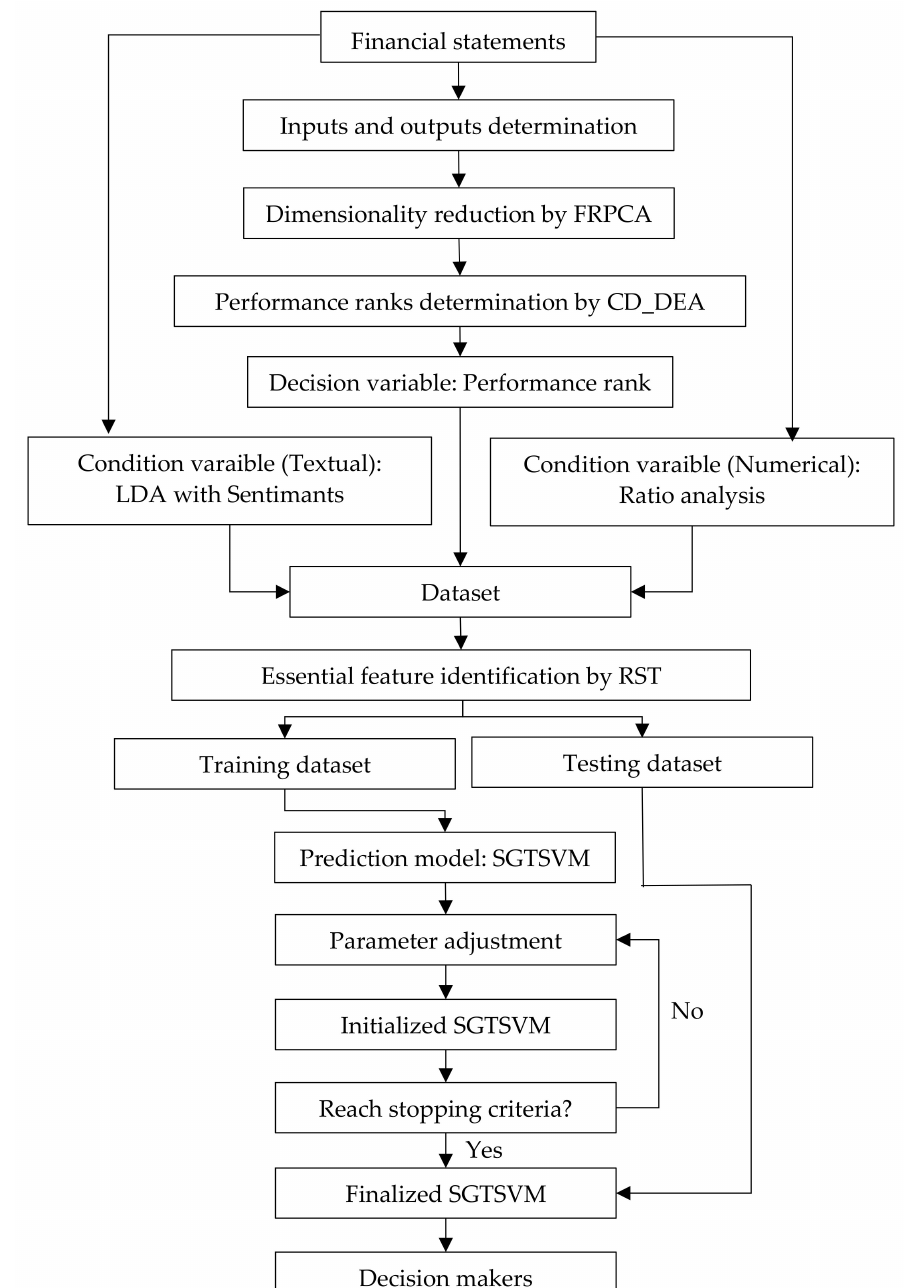
Figure 1. The introduced advanced decision making